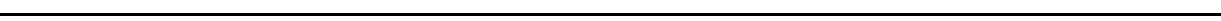
Fig. 8 CCR5 inhibition results in loss of enhanced recruitment of patrolling monocytes, Mafb + AIM + macrophage accumulation and AT acceleration in MT4-MMP-null BMT Ldlr – / – mice. a Scheme depicts the experimental design of CCR5 blocking strategy by Maraviroc (MRV) administration as described in M&M. b Representative orthogonal XZ view of confocal microscopy images of whole mount-stained aortic arch from Ldlr – / – mice transplanted with MT4-MMP + / + or MT4-MMP – / – BM cells, fed the HFD for 3 days and treated with MRV or vehicle. Samples were stained for CD115 (red) and Ly6C (green); elastin auto fl uorescence (green) and nuclei (Hoechst, blue) are also shown. Scale bar, 20 µ m. The bar graph (right) shows the quanti fi cation of the number of patrolling monocytes (CD115 + Ly6C – ) in the aorta lumen; n = 7 vehicle and n = 8 MRV mice per genotype in two independent experiments. c Bar graphs show the quanti fi cation of the number of Mac3 + cells (left), Mac3 + Mafb + cells (middle), and Mac3 + Mafb + AIM + cells (right) in the plaques of BM-transplanted Ldlr – / – mice fed a HFD for 1 week and treated with Maraviroc or vehicle. n = 8 mice per genotype and condition in two independent experiments. d Representative microscopy images of transverse sections of aortic sinus from BM-transplanted Ldlr – / – mice fed a HFD for 8 weeks and treated with Maraviroc or vehicle; sections were labeled for Mac3 (red) and Hoechst (blue; nuclei) (upper, scale bar, 50 µ m) and graph shows the quanti fi cation of the number of Mac3 + cells in the plaque (lower). n = 7 vehicle and n = 8 MRV BM-transplanted mice per genotype in two independent experiments. e Graph showing the lesion area of aortas stained with Oil Red from BM-transplanted Ldlr – / – mice fed a HFD for 8 week and treated with MRV or vehicle. n = 7 and n = 8 mice for Vehicle and MRV mice per genotype in two independent experiments. f Stary scoring (I-VI) of transverse aortic